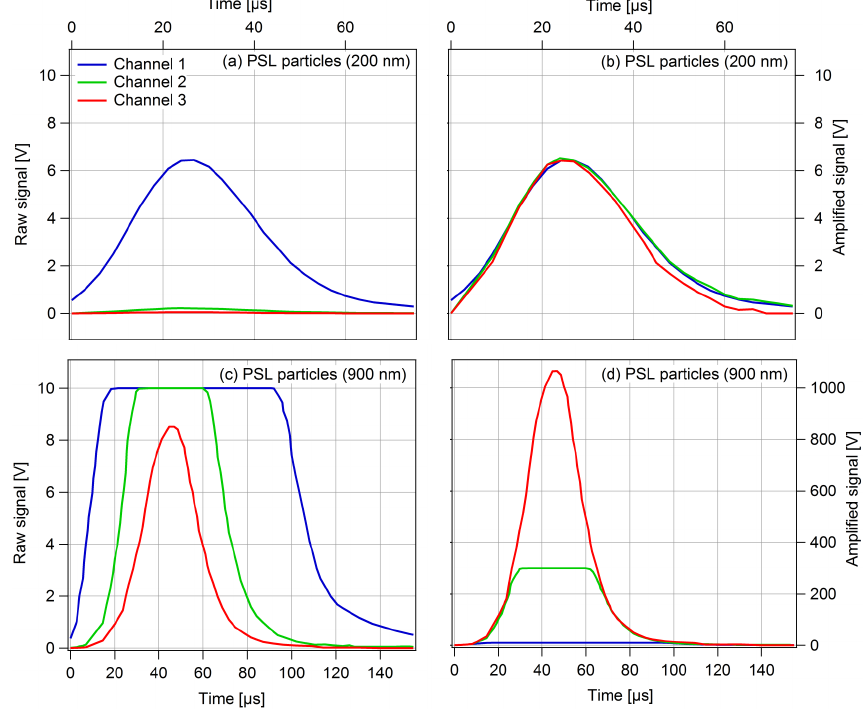
Figure 4. Particle signal pulses measured with all three CARIBIC OPSS channels for 200 and 900nm diameter polystyrene latex (PSL) particles. (a) and (c) show the raw signals at the SMB connectors of the modified KS-93. The amplified signals (factor of 30 for Ch2 and 125 for Ch3), used for data analysis, are shown in (b) and (d) ,